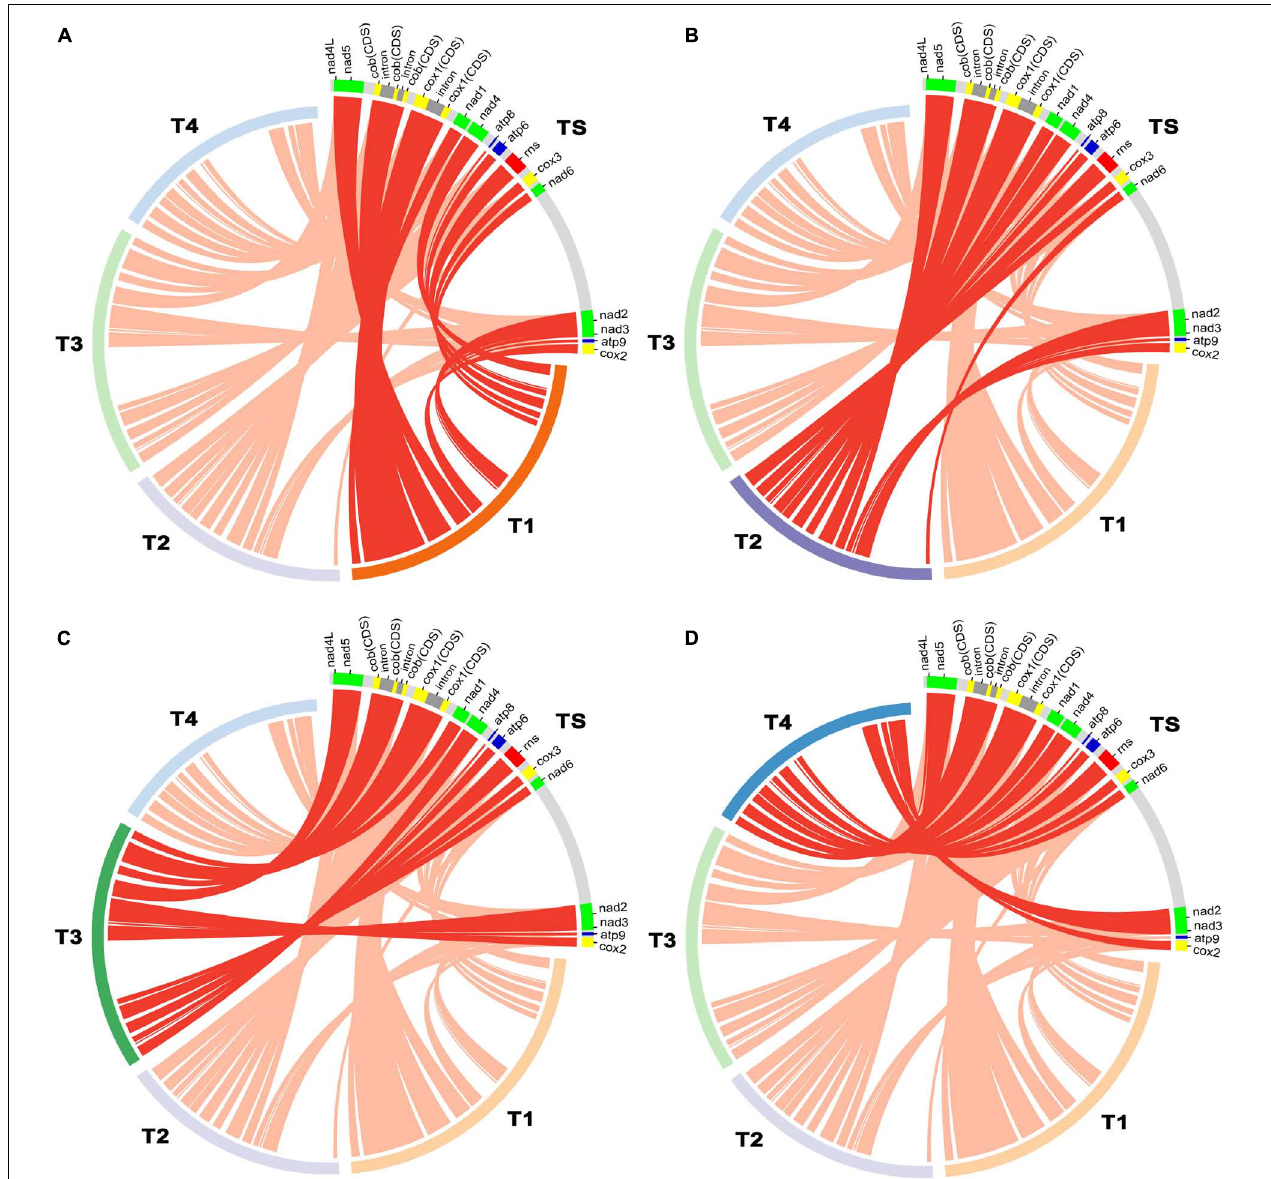
FIGURE 3 | Comparative analysis of mitochondrial gene orders among Trichoderma species. Details of gene components (14 core genes and rns gene) used for the comparative analysis were described in Supplementary Table S5 , and plots were generated using Circos. (A) compared between T. atroviride ATCC 26799 (TS) and T. reesei QM9414 (T1). (B) compared between T. atroviride ATCC 26799 (TS) and T. asperellum B05 (T2). (C) compared between T. atroviride ATCC 26799 (TS) and T. hamatum (T3). (D) compared between T. atroviride ATCC 26799 (TS) and T. gamsii KUC1747